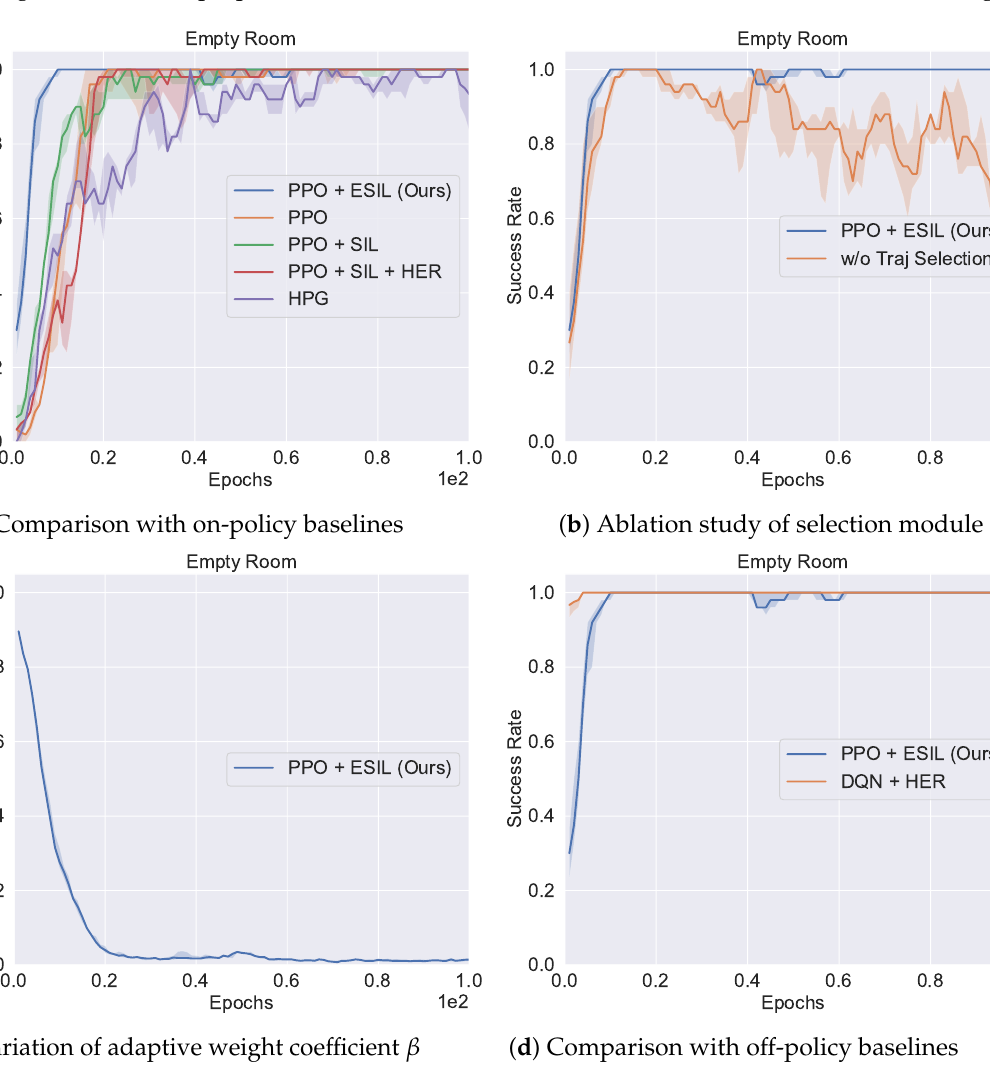
Figure 4. Results of the grid-world environment. ( a ) Comparing the performance of PPO+ESIL between the on-policy approaches. ( b ) An ablation study on the trajectory selection module. ( c ) The variation of adaptive weight coefficient β through training. ( d ) Comparison of the performance of PPO+ESIL to an off-policy approach: